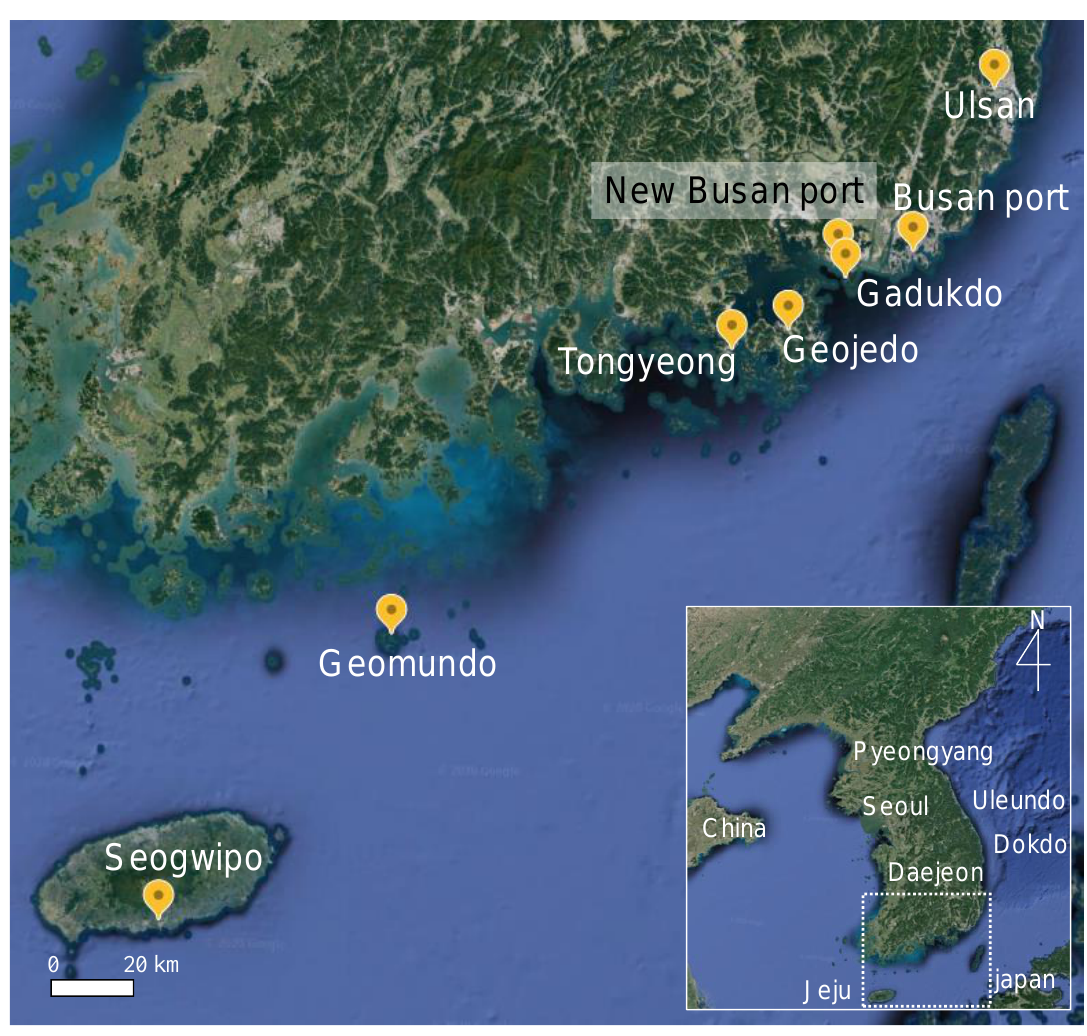
Figure 4. Major analysis points on the satellite image map .